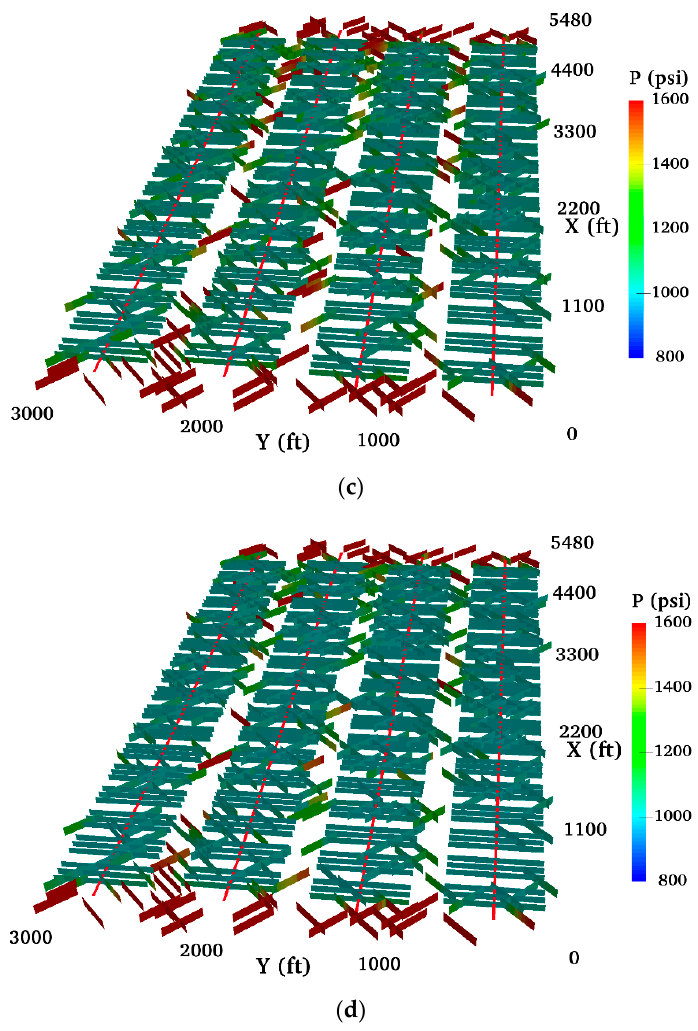
Figure 12. Pressure distributions in the fractures for the optimal well spacing scenario: ( a ) after 1 year; ( b ) after 5 years; ( c ) after 10 years; and ( d ) after 20 years.